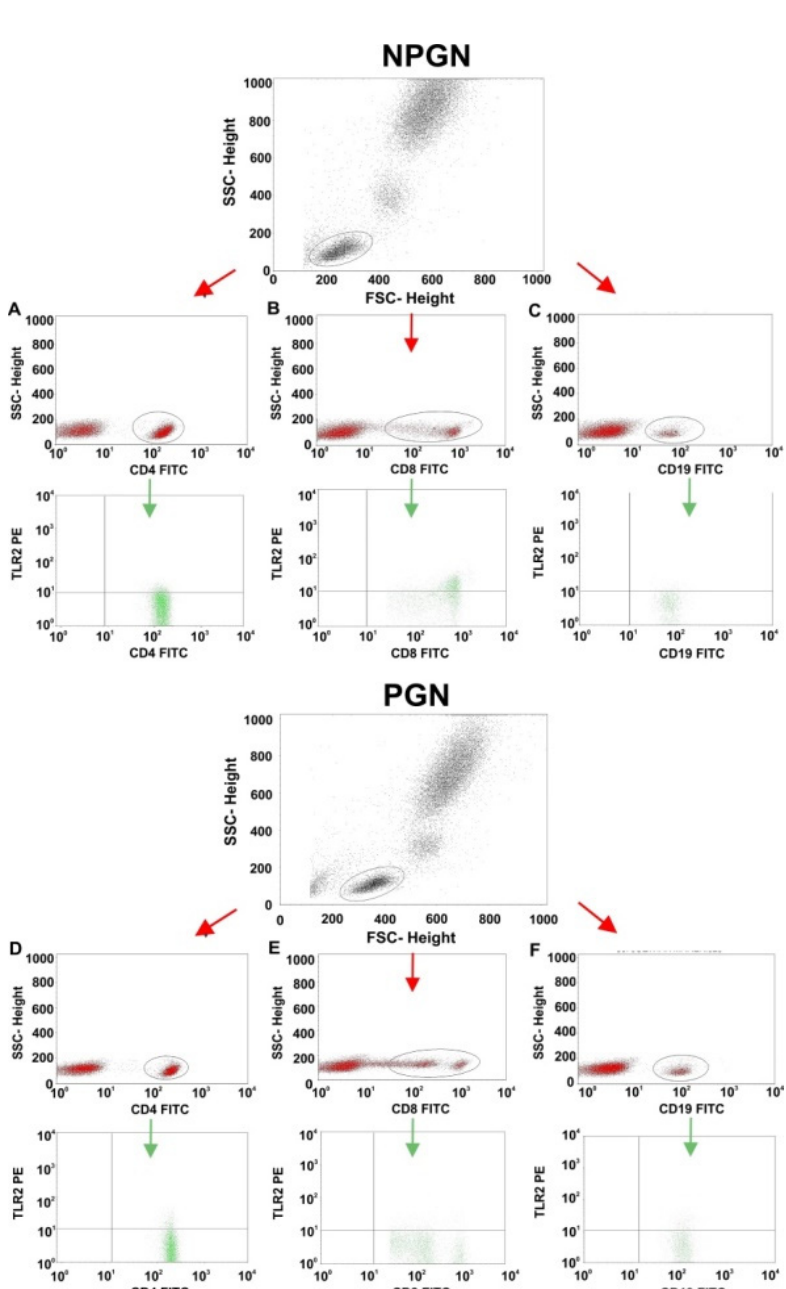
Figure A1. Sample analysis of CD4+/CD8+/TLR2+ T lymphocytes and CD19+/TLR2+ B lymphocytes in NPGN and PGN patients. ( A ). Sample analysis of CD4+/ TLR2+ T lymphocytes in NPGN patients. ( B ). Sample analysis of CD8+/ TLR2+ T lymphocytes in NPGN patients. ( C ). Sample analysis of CD19+/ TLR2+ B lymphocytes in NPGN patients. ( D ). Sample analysis of CD4+/ TLR2+ T lymphocytes in PGN patients. ( E ). Sample analysis of CD8+/ TLR2+ T lymphocytes in PGN patients. ( F ). Sample analysis of CD19+/ TLR2+ B lymphocytes in PGN patients.